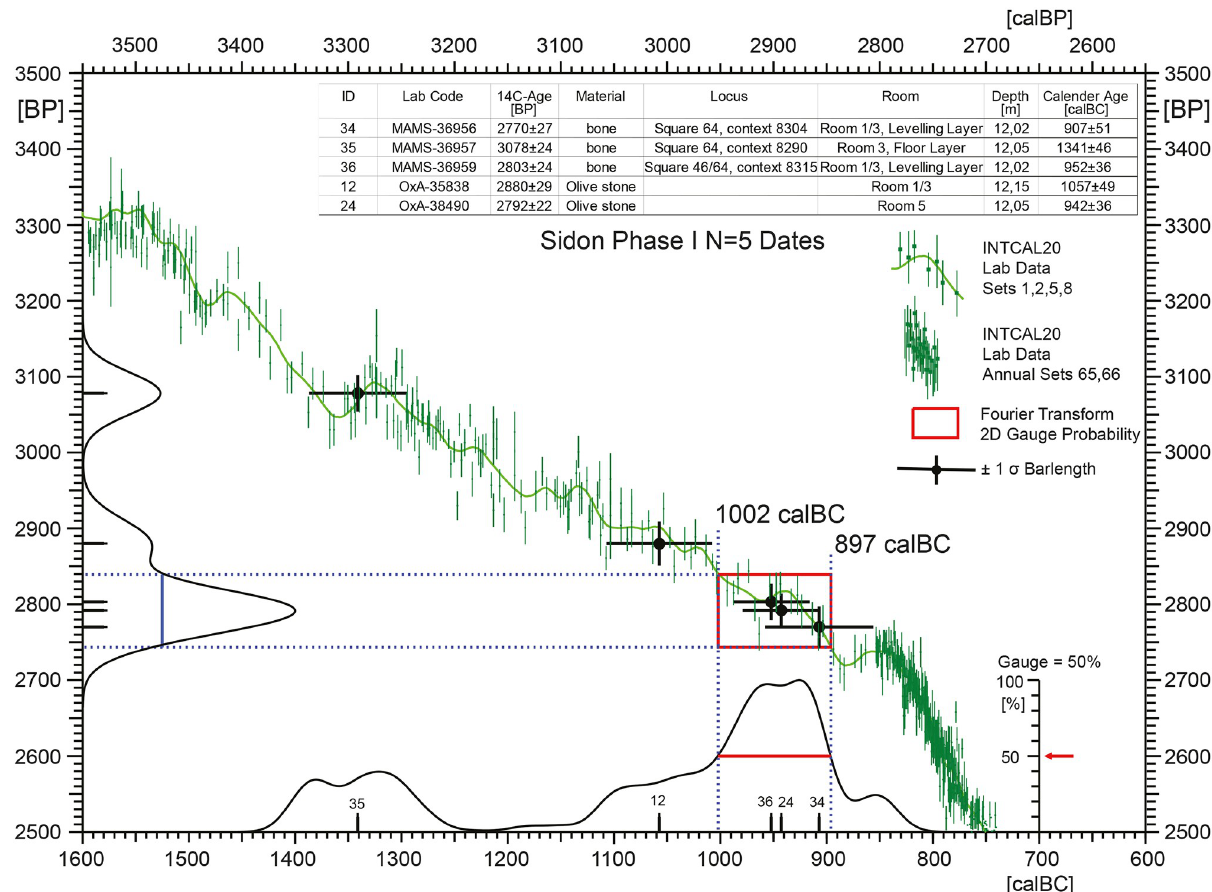
Fig 14. Application of the probability gauge method to Sidon Phase I dates, used to estimate the Begin and End of the phase. The available N = 5 dates are shown as single-age crossbars ( ± 68% confidence), with sample ID according to Table 1. The red-coloured rectangle projected onto the IntCal20 curve shows the visually optimised central area of 2D-dating probability. The underlying gauge value of g = 50% was chosen in order to enclose simultaneously as much central area of the uncalibrated ( 14 C-scale) and calibrated (calendric scale) distributions as possible. The result is that Sidon Phase I begins at 1000 ± 40 calBC and ends at 900 ± 40 calBC (rounded ages, with dating errors estimated from underlying single dates (cf. Table